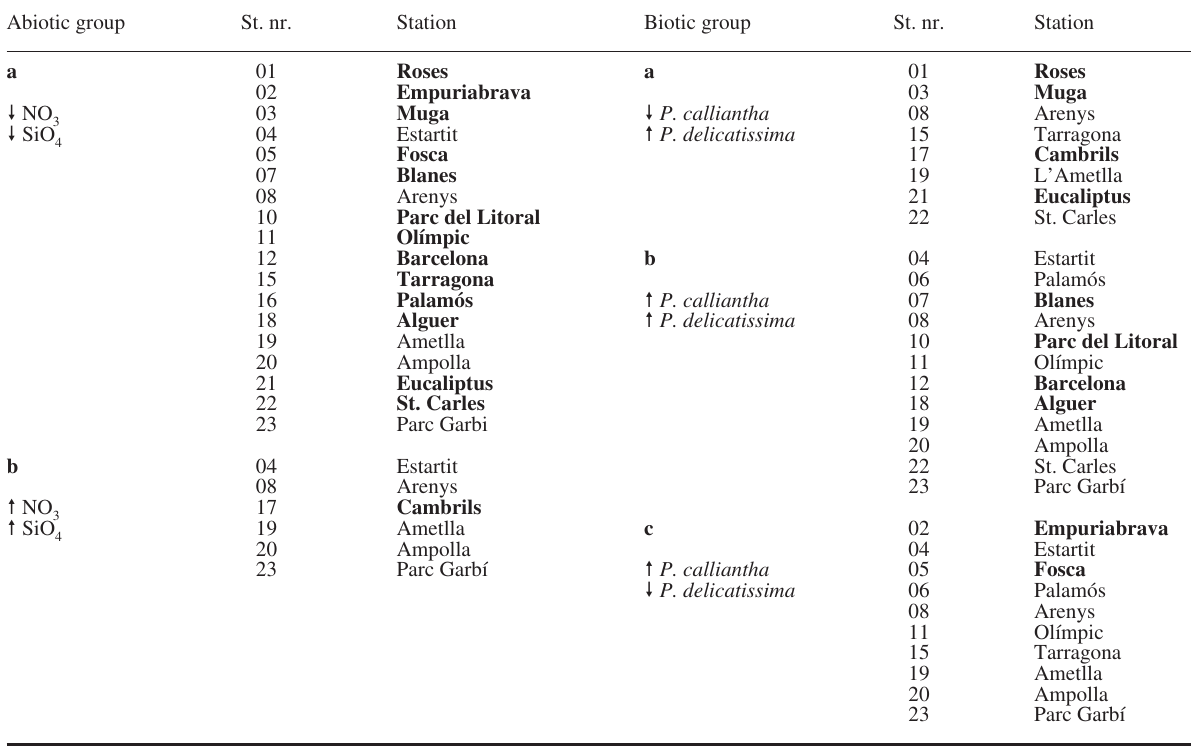
Table 5. – Pseudo-nitzschia abundance (mean ± standard deviations) of each biotic group and abiotic variables (mean ± standard deviations) Biotic group